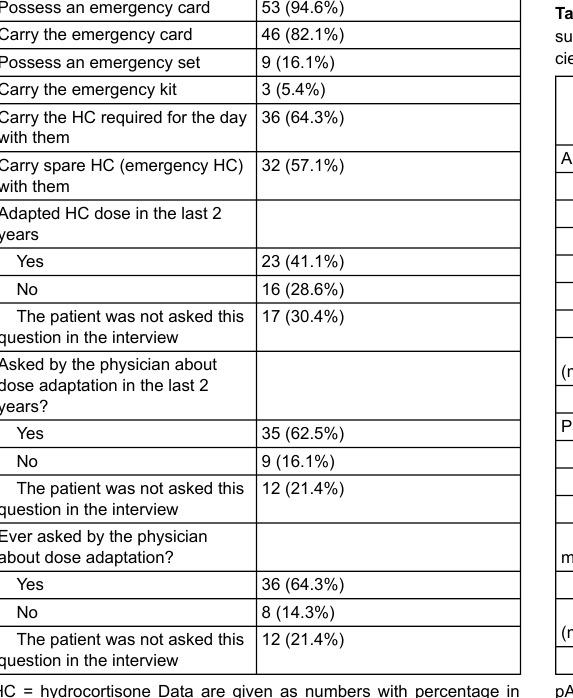
Table 4: Characteristics of equipment and preventive measures in 56 patients with adrenal insufficiency.